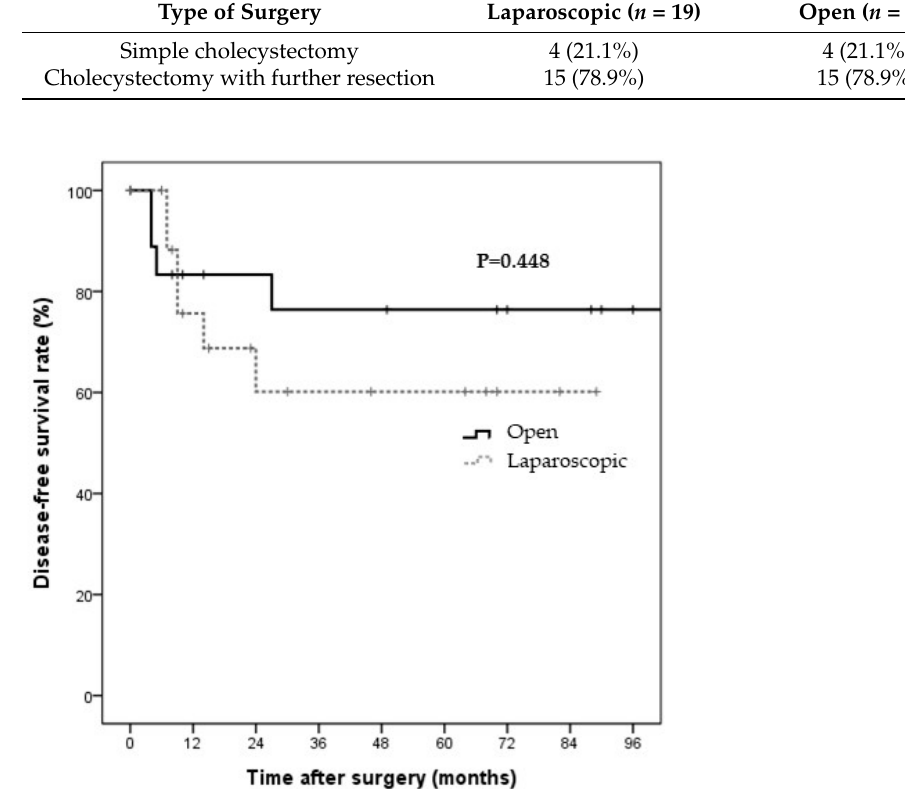
Figure 3. Disease-free survival in the propensity-score-matched patients by surgery type. The disease-free survival rate in the propensity-score-matched patients at three years was 60.2% and 76.4% in the laparoscopic and open surgery groups, respectively. The two groups showed no significant difference in recurrence ( p = 0.448).